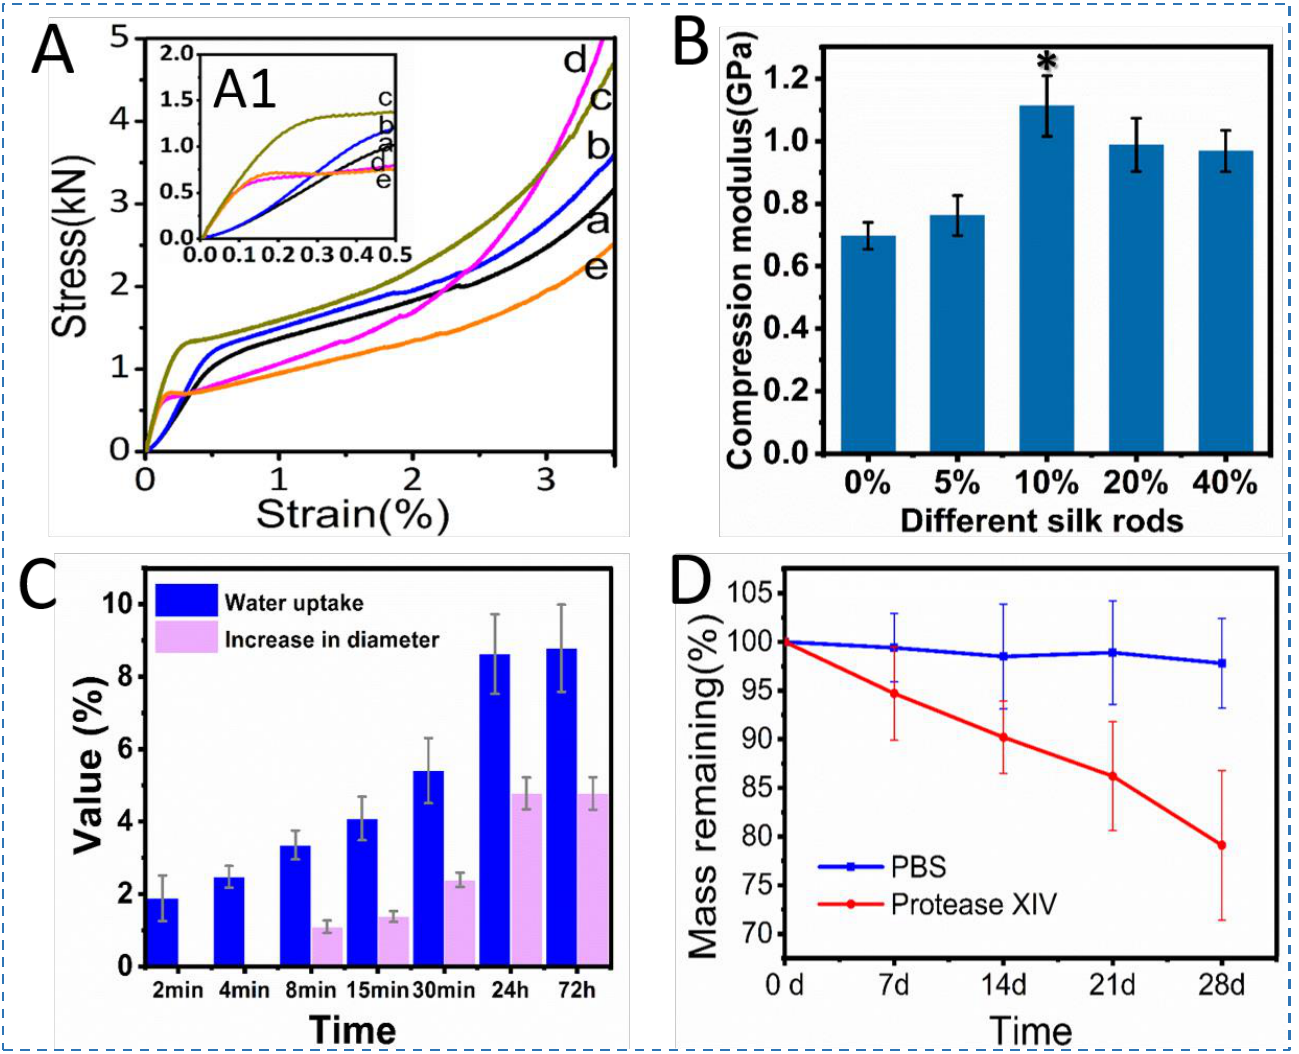
Figure 5. Mechanical and biodegradable properties of different silk rods. ( A , A1 ) represent stress-